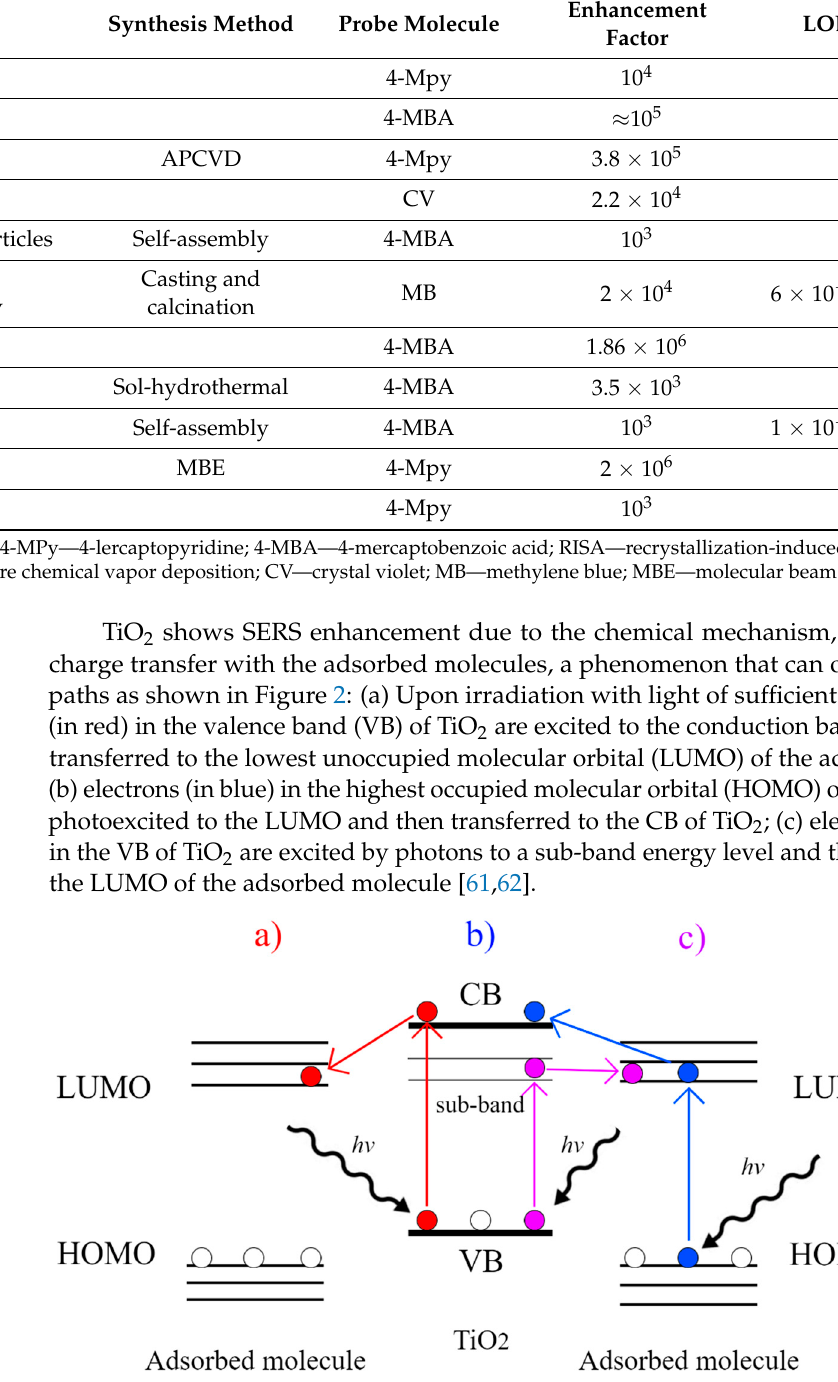
Figure 3. Phototatalytic mechanism of a TiO 2 /MNP substrate to degrade adsorbed molecules. Among the TiO 2 nanostructures that have been studied as supports for MNPs, nano- tube arrays prepared by anodization have shown promising properties to build SERS plat- forms. Several features make them appropriate for this purpose: (a) they can provide an appropriate acidic surface for the MNPs deposition [20]; (b) the high surface area of TiO 2